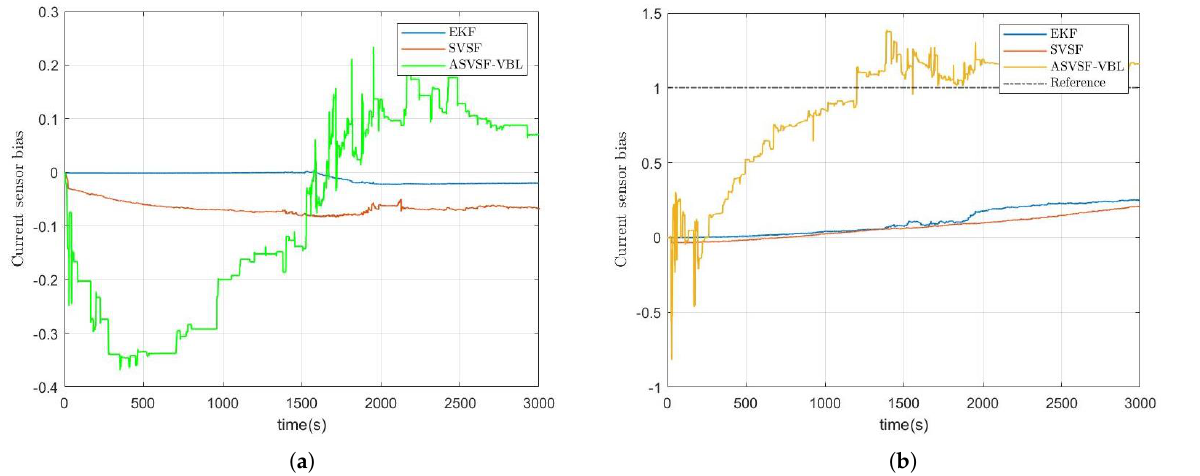
Figure 10. ( a ) Estimated current bias for an ideal scenario, ( b ) Estimated current bias in presence of noise and current